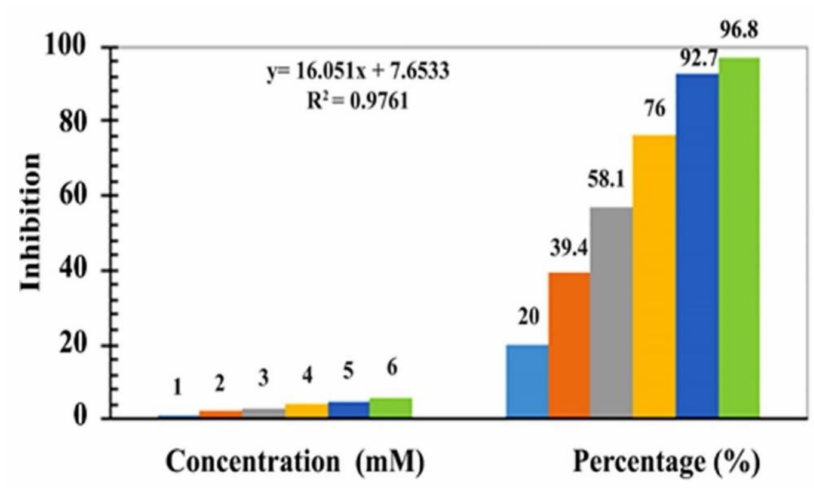
Figure 7. Graphical representation of antioxidant activities of ascorbic acid (standard).